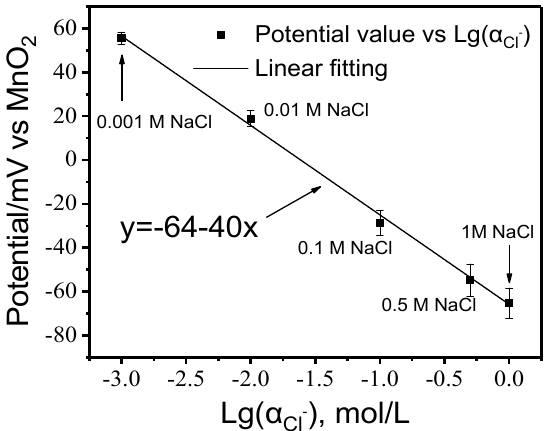
Figure 3. The calibration curve of Ag/AgCl in synthetic pore solution.